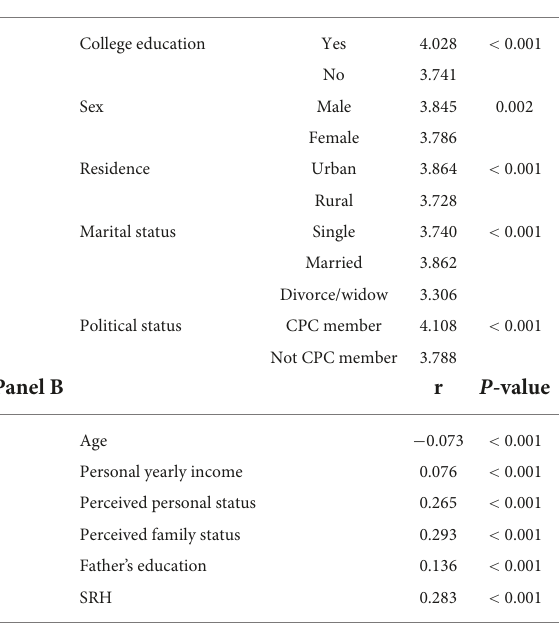
differences in happiness. Panel A